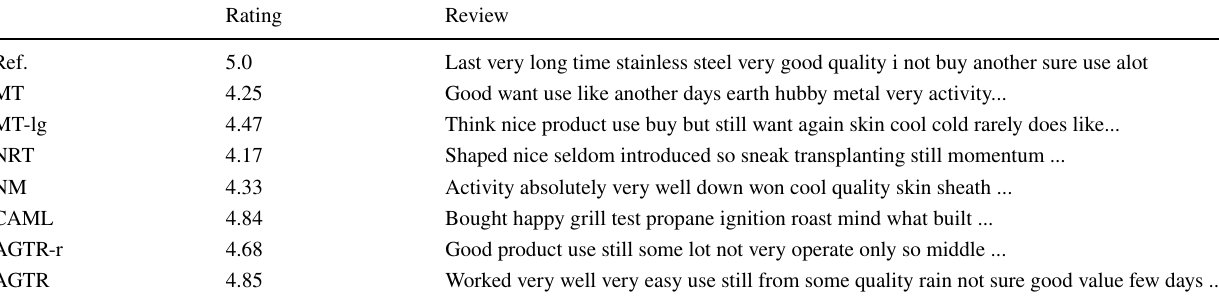
Table 7 Examples of the predicted ratings and the generated reviews (Ref. denotes the ground-truth review and rating)